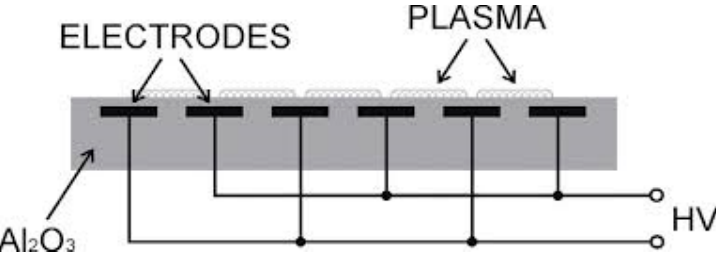
Figure 1. Di ff use coplanar surface barrier Figure 1. Diffuse coplanar surface barrier discharge.